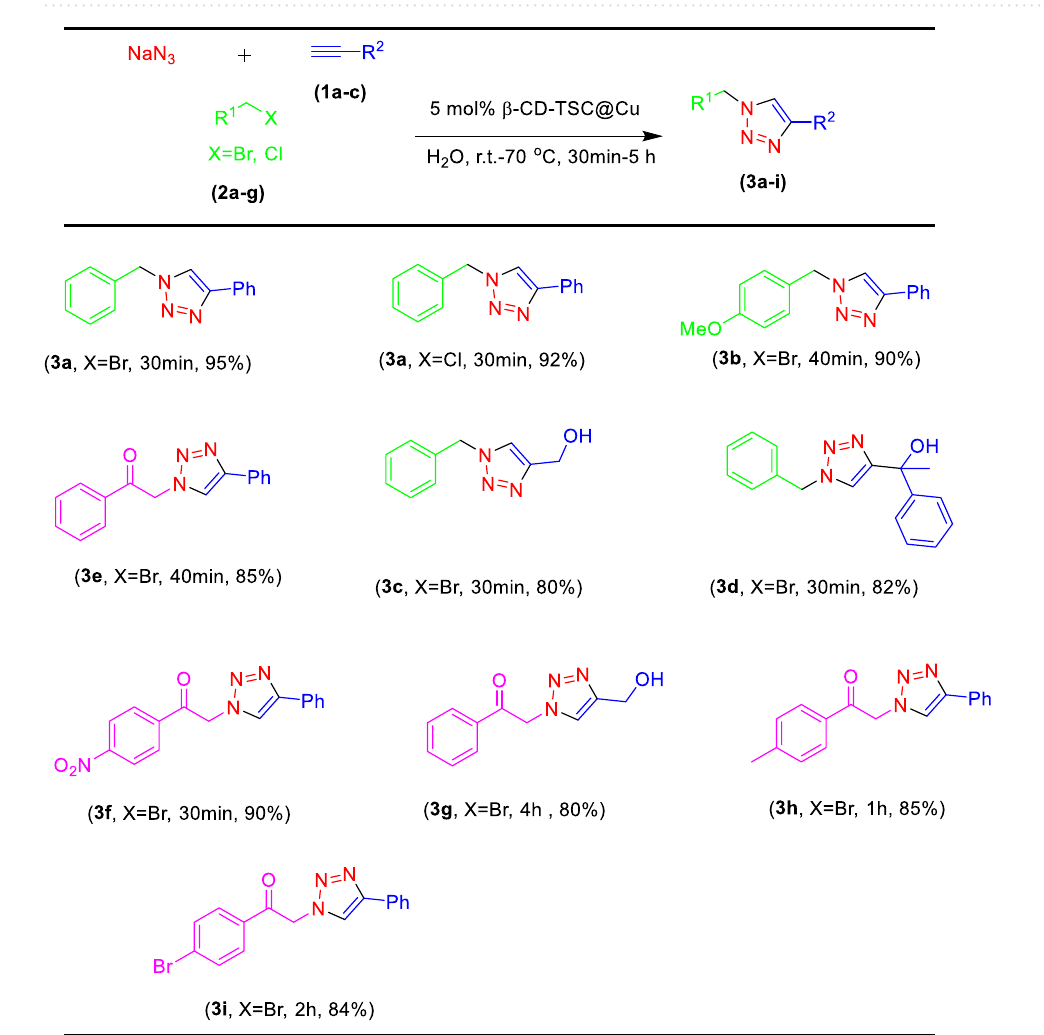
Table 1. The optimization results obtained for the reaction of benzyl bromide with phenylacetylene and sodium azide as a model reaction. a Solvent (2 mL). b Under N 2 or Ar atmosphere. c With by-product. Bold indicates the best result of our experiments.